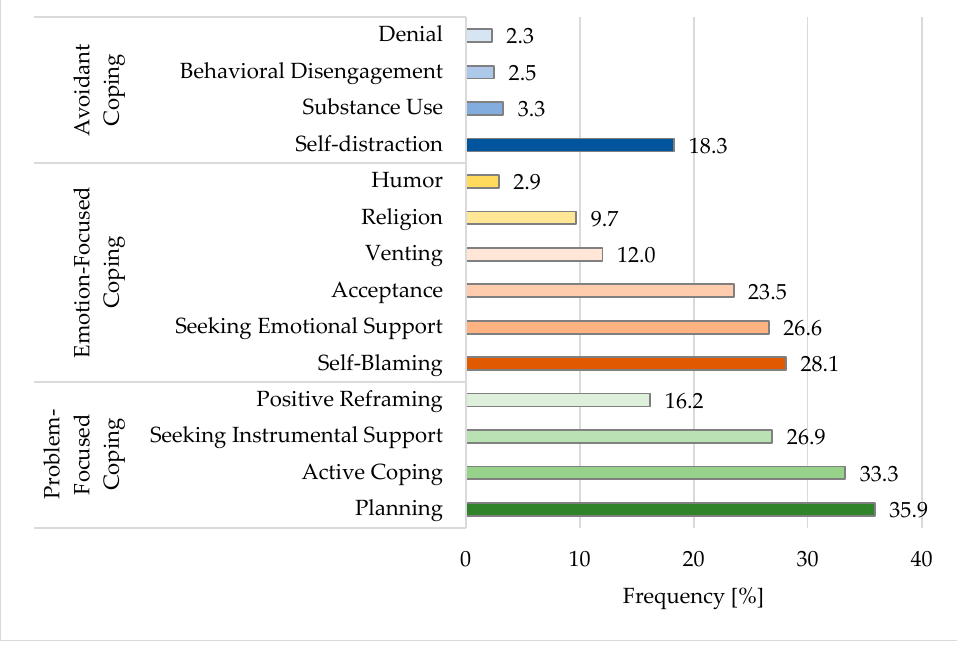
Figure 3. Frequency (percentage of subjects) of choosing coping strategies among subjects present- ing TMD symptoms, possible AB and SB.